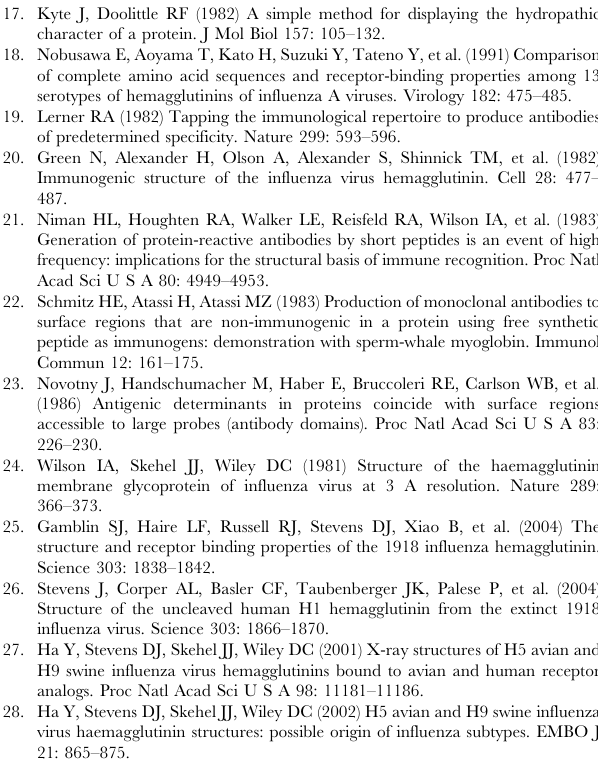
Table S1 Correlation score of H2 with other subtypes at each amino acid residue in HA1 domain. The data obtained from muscle and compass alignments was tabulated. The H3 sequence (PDB: 1HGJ) was added to follow the H3 numbering. The consensus residue at each amino acid position, the frequency of consensus residue, correlation of H2 with other subtypes and the final conservation score at each amino acid position is